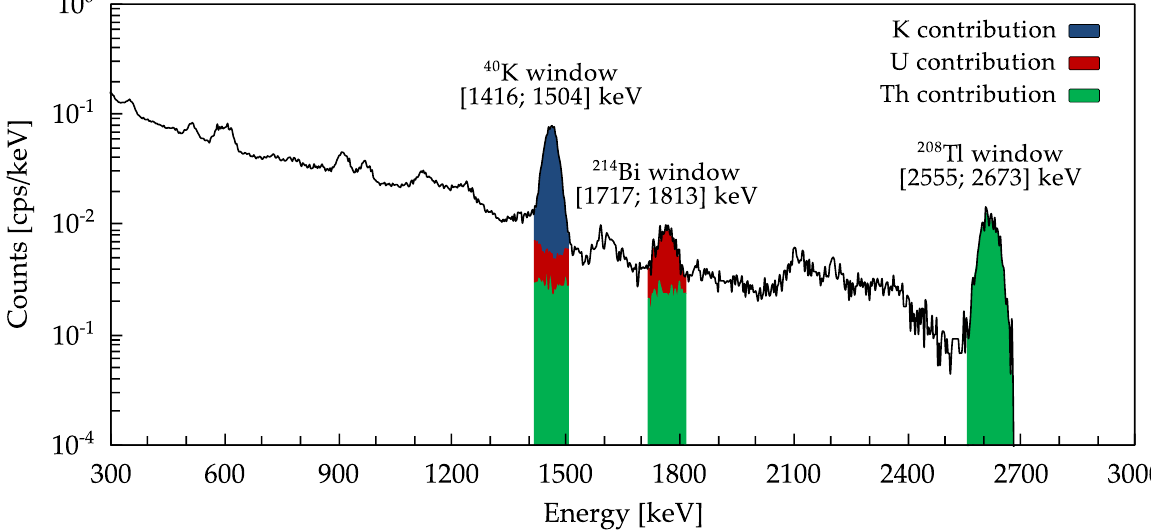
Figure 12. WAM procedure is applied to an experimental gamma spectrum measured by CORSAIR. The analysis is performed on the 40 K, 214 Bi and 208 Tl energy windows, representative of the K, U and Th decay chains, respectively. For each window, the method enables the estimation of the contributions coming from the different decay chains, here depicted in different